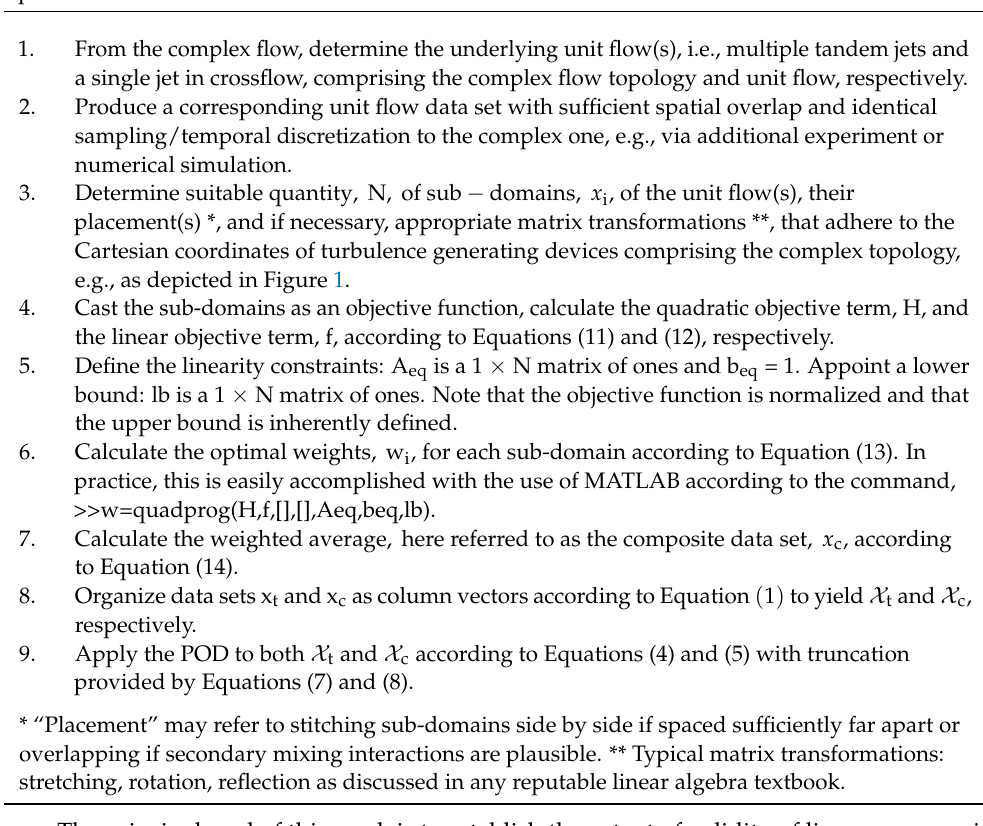
Algorithm 1. Given a two-dimensional, high spatio-temporal complex flow topology U i ( x i ,t ) produced by experiment or numerical simulation and here prescribed as the ‘true’ data set x t , proceed as